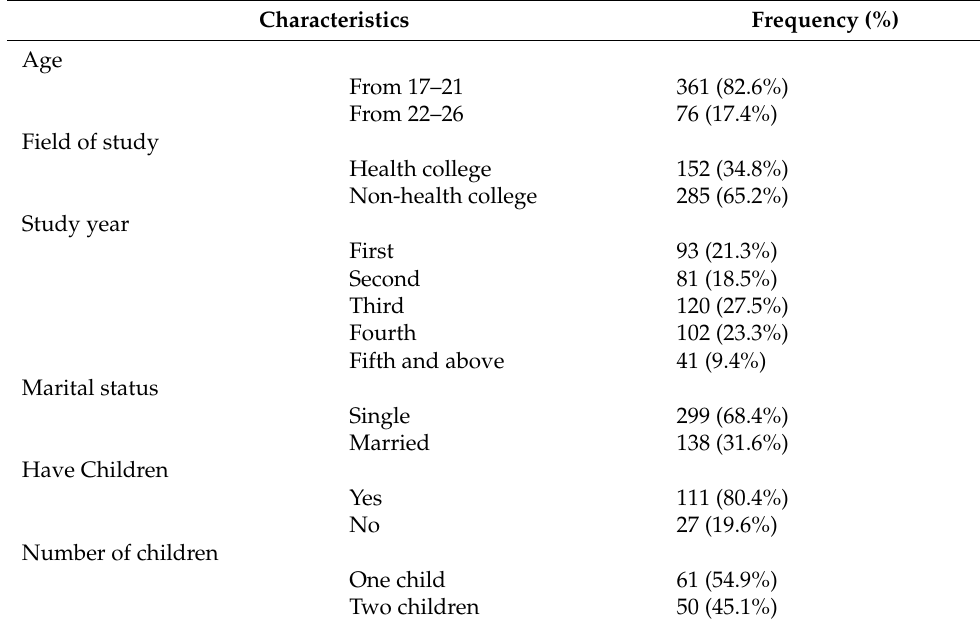
Table 1. Socio-demographic profile of 436 undergraduate female students who responded to the survey.